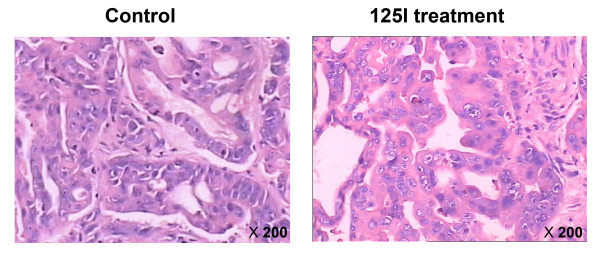
 Pathology of 125 I implanted gastric cancer. Representative HE stained sections from the control and 125I treatment groups 28 d after 125 I seed implantation were prepared as described in the Materials and Methods section.